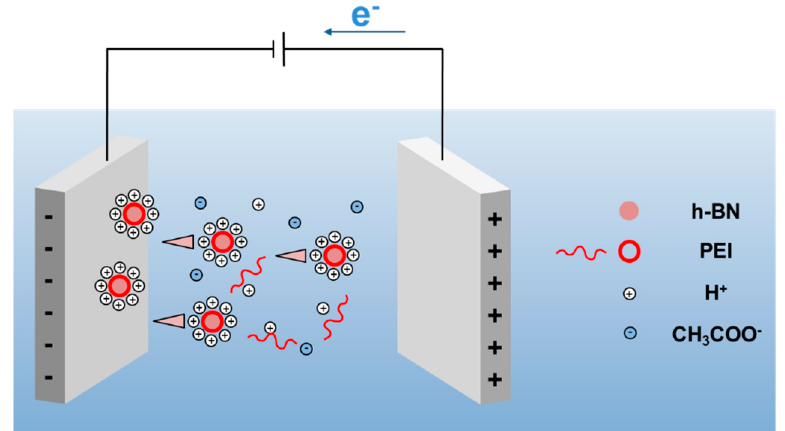
Figure 7. Deposition process of h-BN/PEI particles.